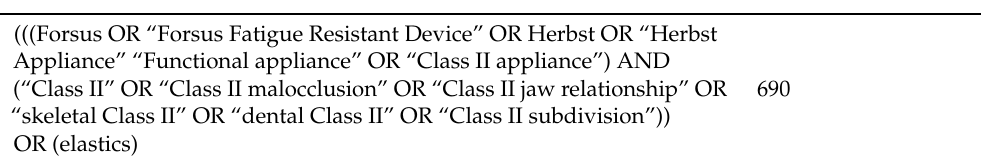
Table A8. Screenatron Systematic Review Accelerator (advanced